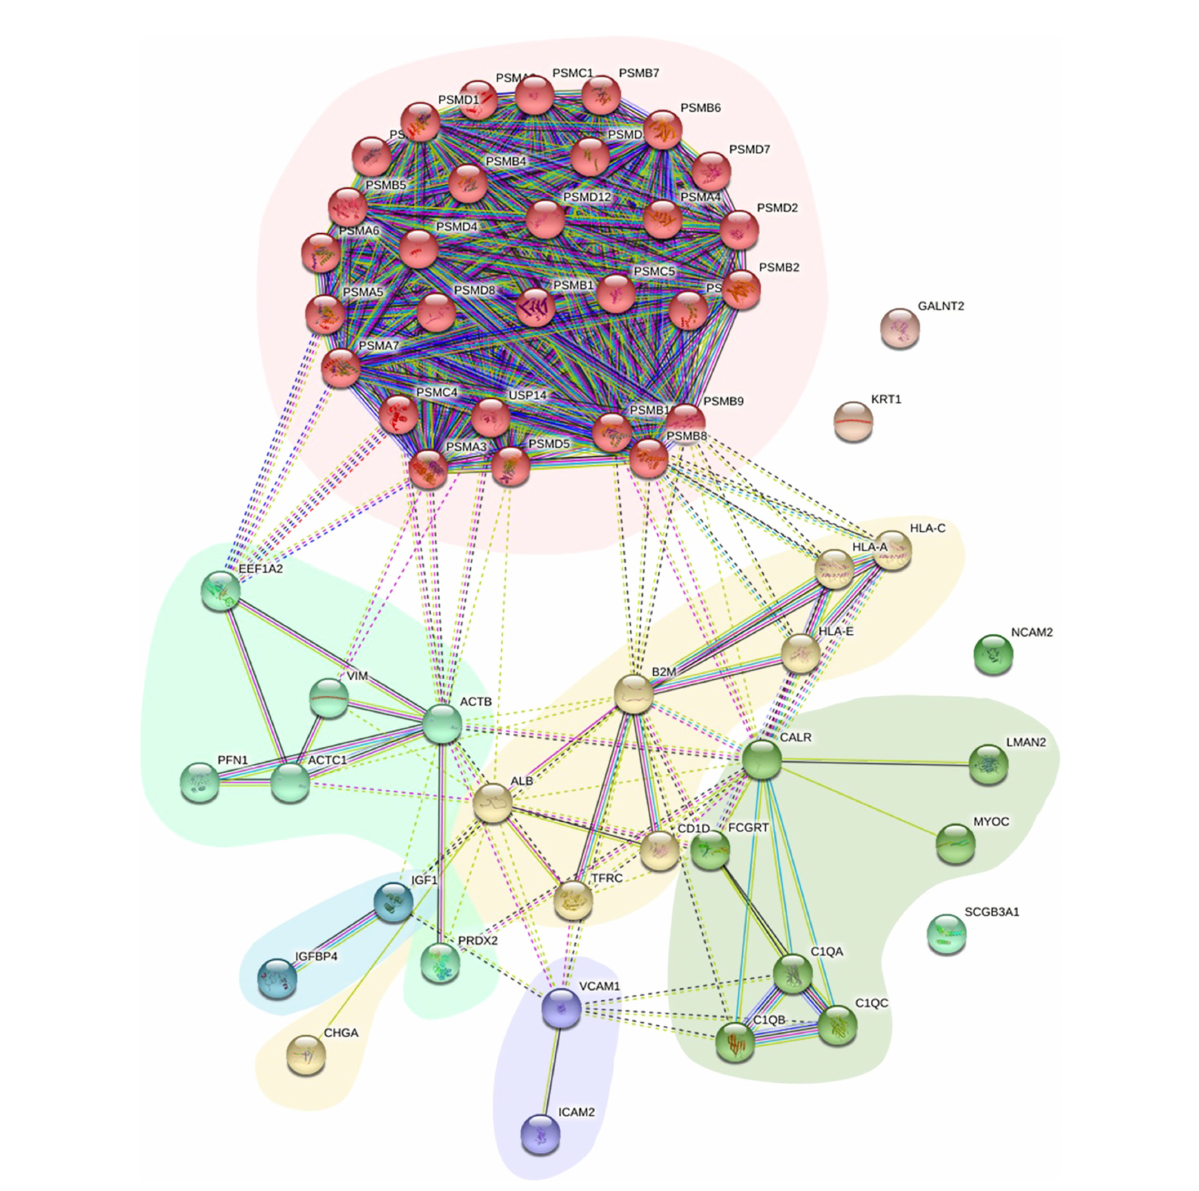
FIGURE 4 PPI network of DEPs. The PPI network displays the function and signaling connection between the DEPs. Six clusters were generated based on function and labeled with different colors as